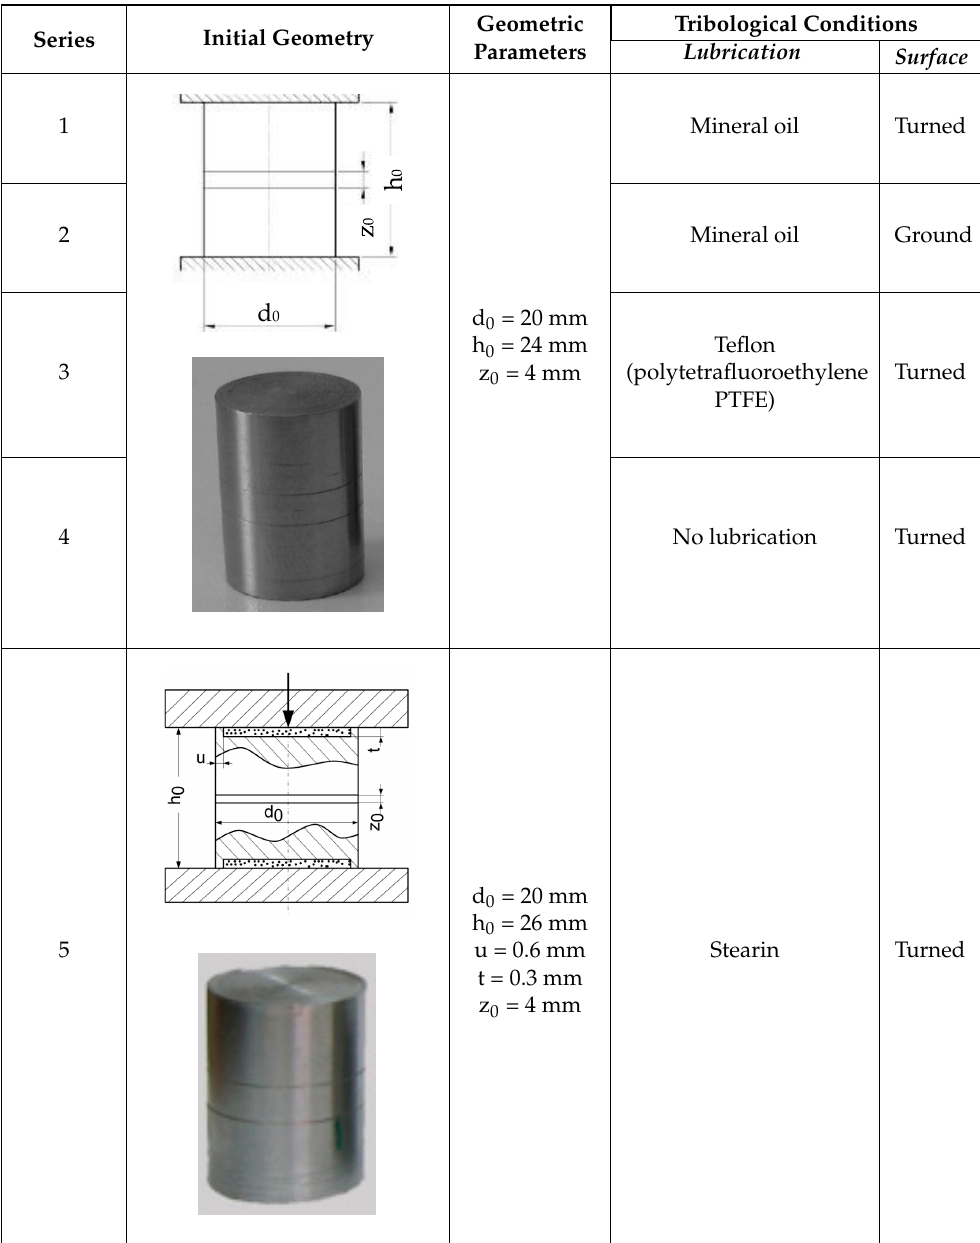
Table 1. Upsetting test conditions.